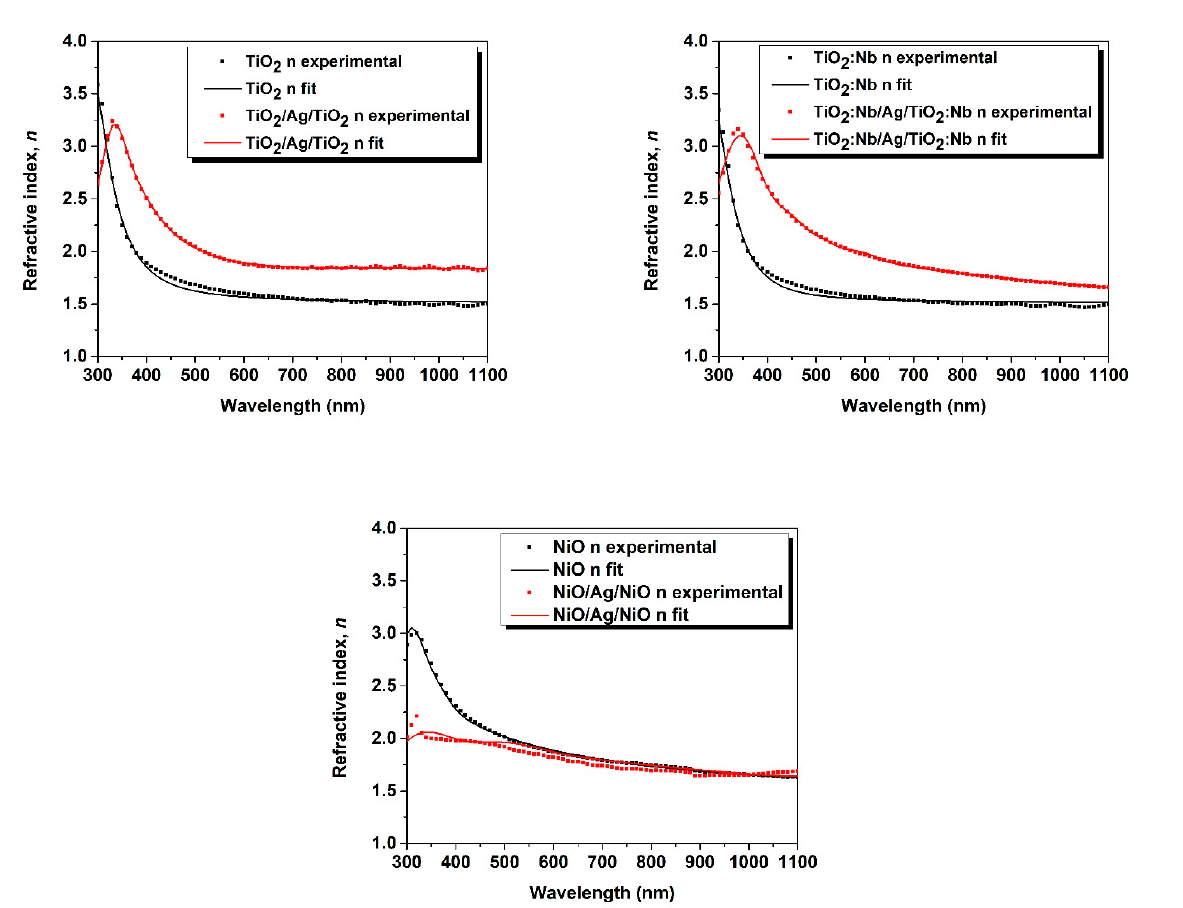
Figure 6. Ellipsometry experimental data (dotted lines) fitted by theoretically calculated curves (continuous lines) from the ellipsometric models, for single and three-layer samples.